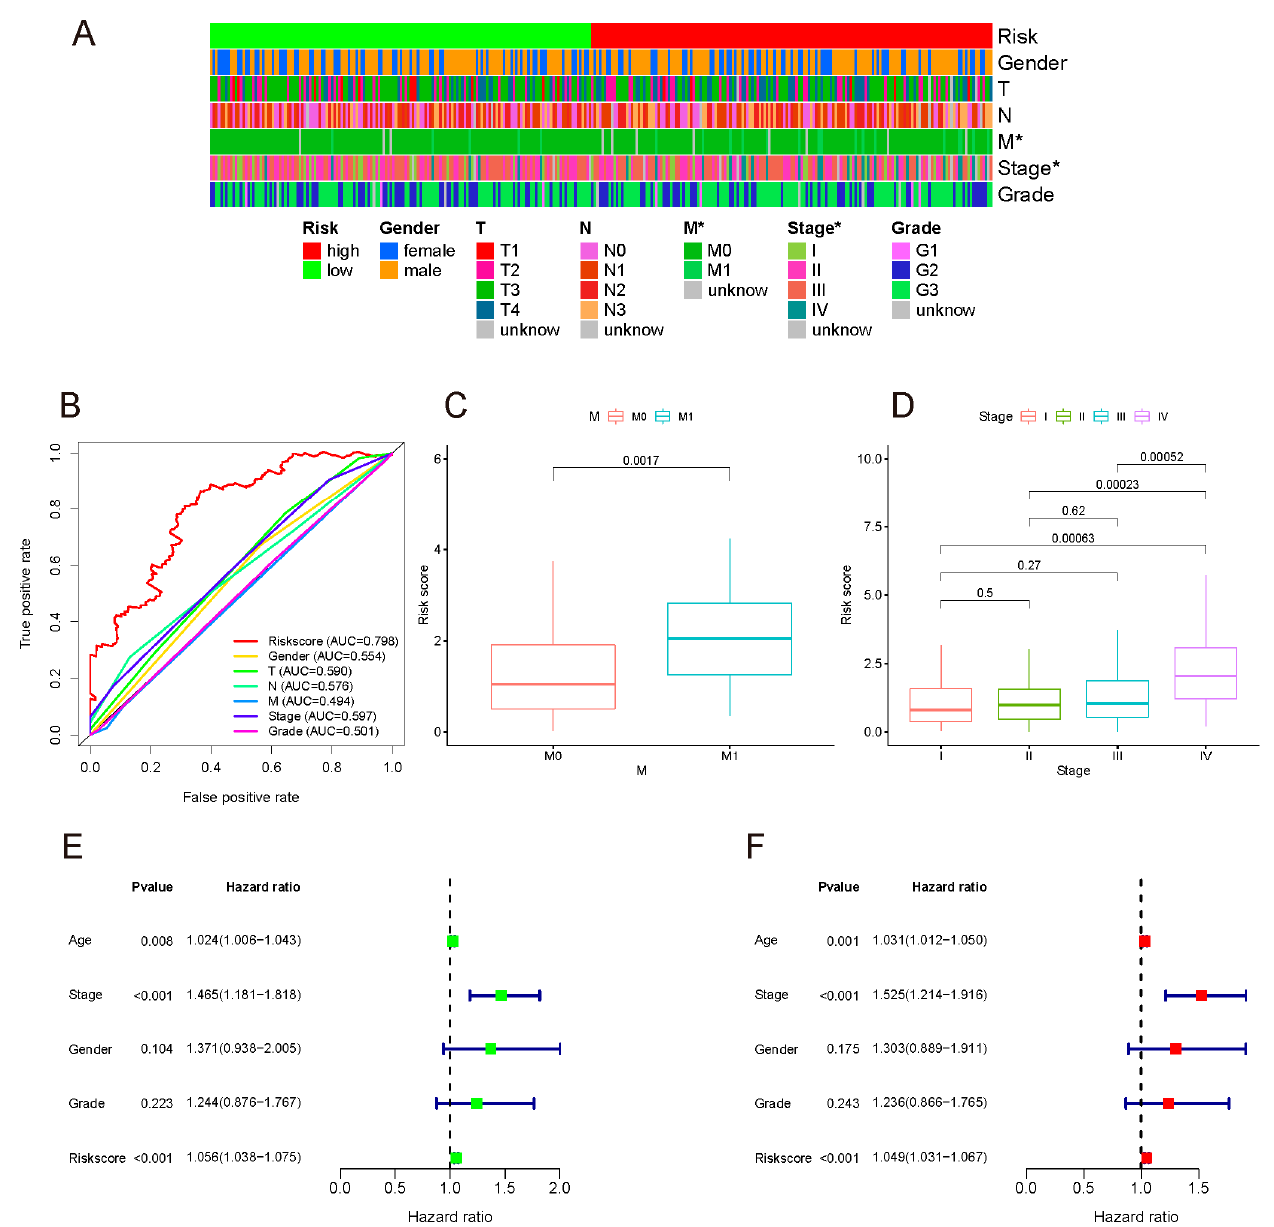
Figure 5. ( A ) Band diagram outlining the distribution of clinicopathological characteristics in the whole sample sorted by a risk score ranging from low to high. Label: p < 0.05 = *. ( B ) 5-year ROC comparing the performance of different signatures. Our model outperformed the others. ( C , D ) M stage and tumor stage were positively related to the risk score. Univariate ( E ) and multivariate ( F ) analyses confirmed that the model could be used to independently predict